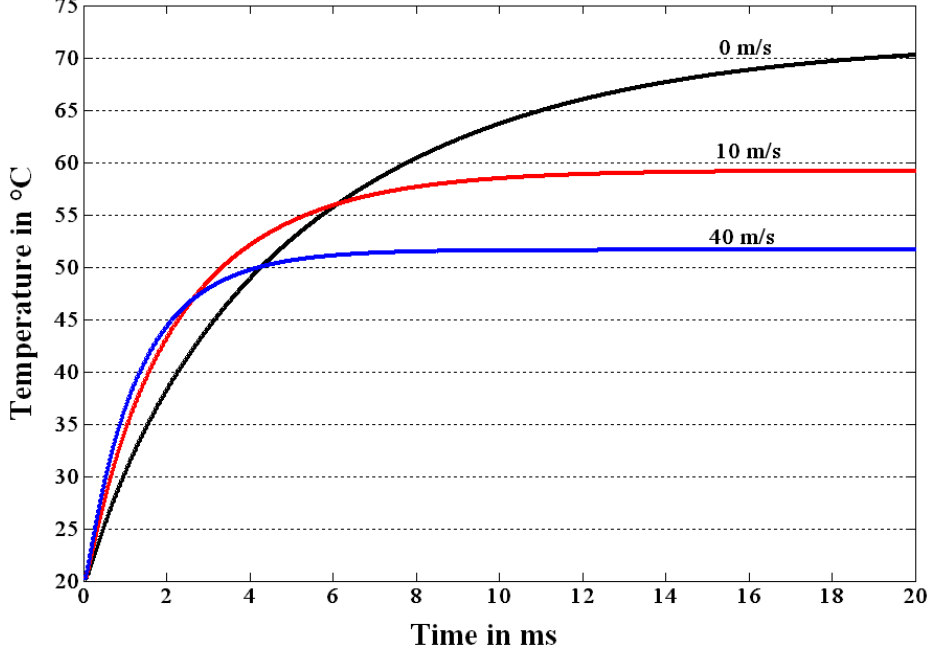
Figure 4 . Temporal changes of thermal flow sensor signal (thermopile) for different values of air velocities according to the theoretical model. For this 1D model, the direction of the flow is not taken into account, and therefore the both thermopiles have exactly the same